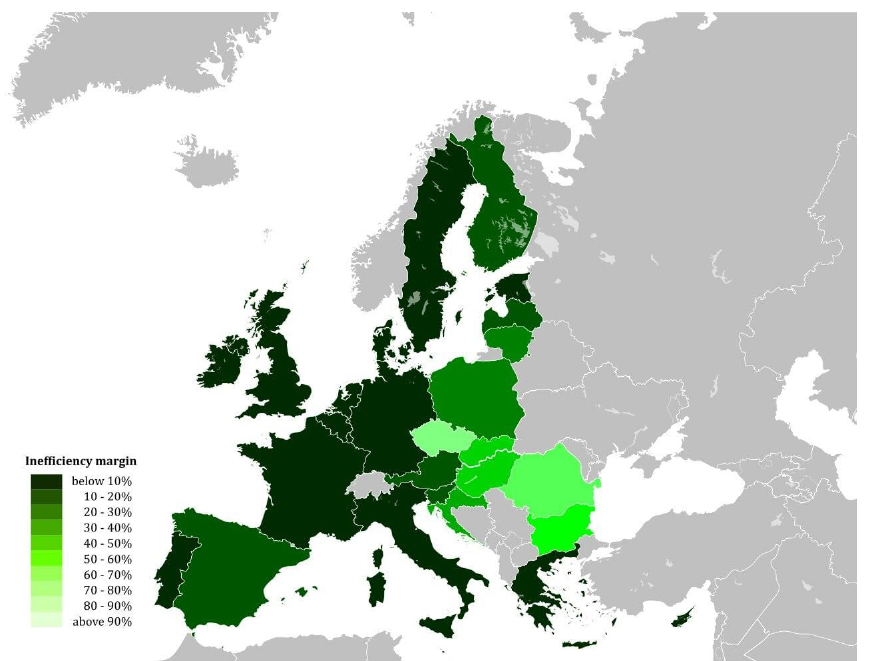
Figure 1. Average efficiency scores across countries on a map of Europe.